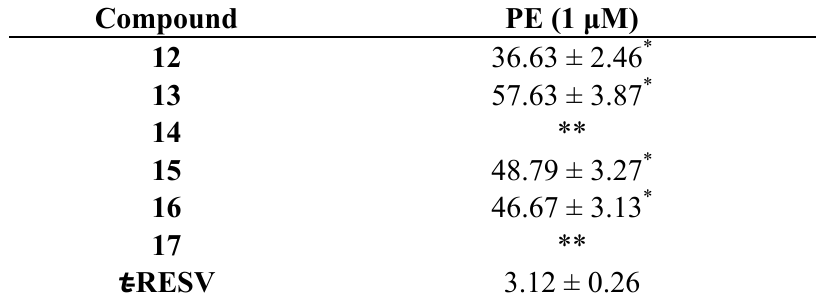
in μ M) of tested compounds. 50